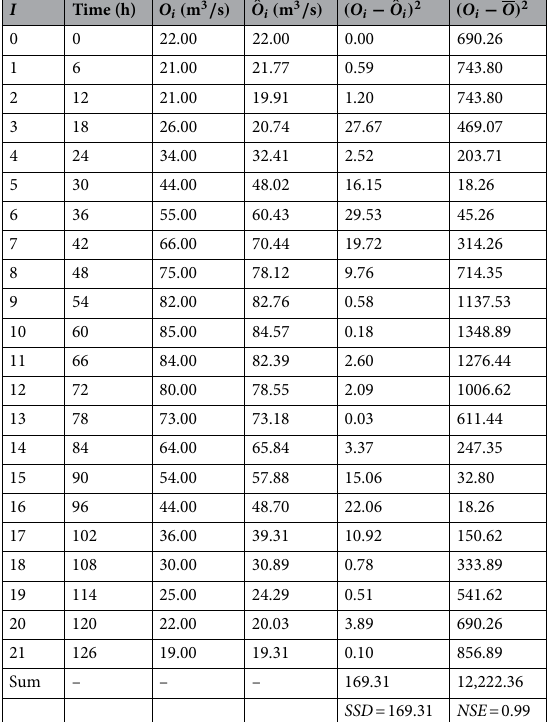
Table 3. Observed and average simulated outflow timeseries for the Wilson benchmark